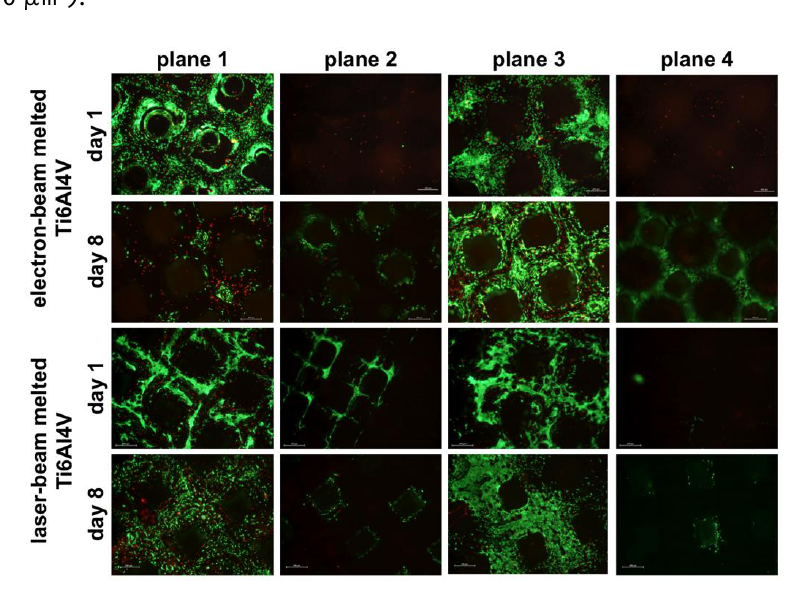
Figure 2. Exemplary illustration of the viability of human bone cells on the four planes of the titanium scaffolds on day 1 and day 8 ( n = 3; green = living cells; red = dead cells; scale bar: 500